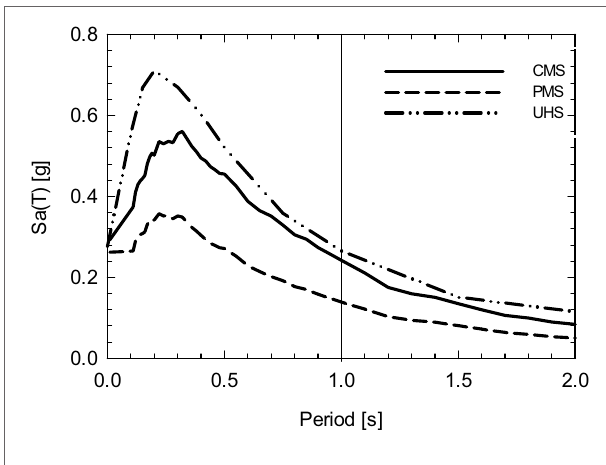
FigUre 6 | conditional mean spectrum (cMs), predicted mean spectrum (PMs), and uniform hazard spectrum (Uhs) in soveria Mannelli, italy .